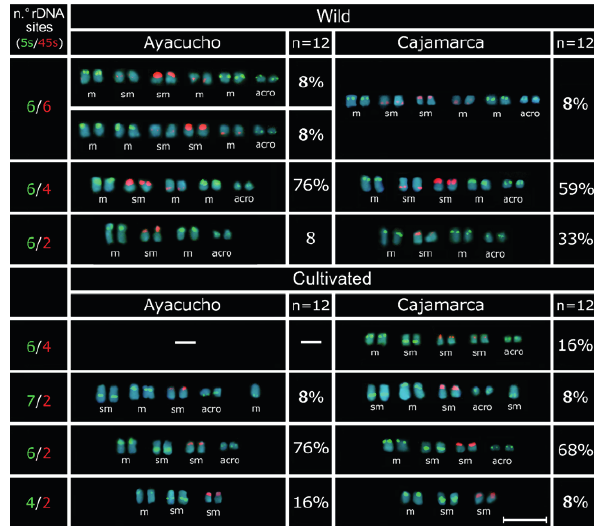
Figure 4 Chromosomes that showed hybridization of the 5s and 45s rDNA probes between the best 12 metaphases for each popula- tion, encompassing at least one metaphase for each of the combi- nations of the number of 5s and 45s rDNA sites reported for each population of goldenberry. m=metacentric, sm=submetacentric,